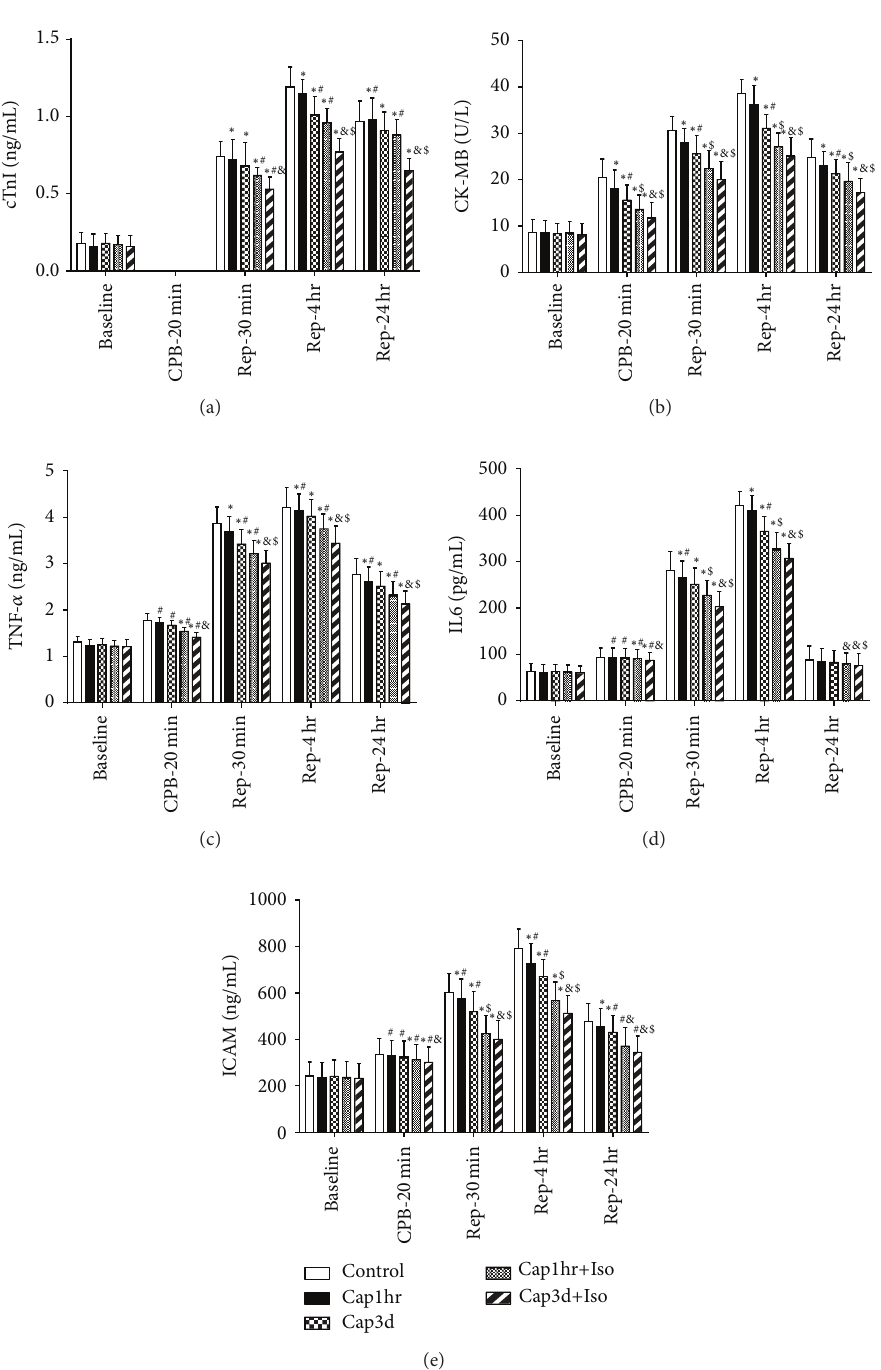
Figure 2: Isoflurane (Iso) and captopril (Cap) attenuated postischemic myocardial cellular injury and reduced proinflammatory cytokines releaseinpatients.(a)PlasmacardiactroponinI(cTnI),(b)plasmacreatinekinase-(CK-)MB,(c)plasmatumornecrosisfactor-(TNF-) 𝛼 ,(d) plasma interleukin- (IL-) 6, and (e) plasma intercellular adhesion molecule (ICAM). Control: untreated control; Cap1hr: captopril treatment for 1h before surgery (12.5 mg, p.o., 1h before surgery); Cap3d: captopril treatment for 3 days (12.5mg, p.o., 3 times a day) before surgery; Cap1hr+Iso: captopril treatment for 1h in combination with inhalational isoflurane (Iso) at 1.1% end tidal concentration administrated for 30 min before CPB; Cap3d+Iso: captopril treatment for 3 days in combination with Iso before CPB. Data are shown as means ± SD, with 𝑛 = 20 per group. # 𝑃 < 0.05 versus Baseline, ∗ 𝑃 < 0.05 and $ 𝑃 < 0.01 versus Control, and & 𝑃 < 0.05 versus